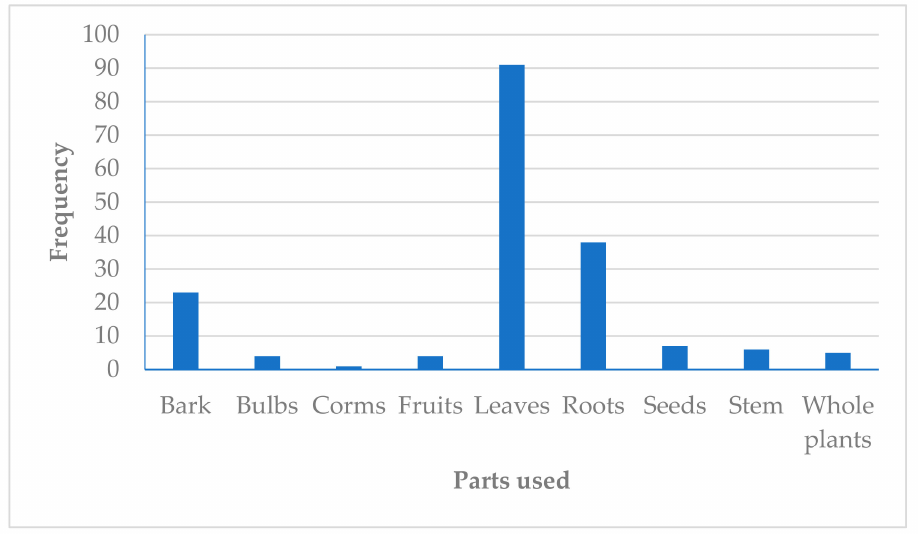
Figure 3. Frequency ( n ) of medicinal plant parts used as herbal preparations for managing headache in